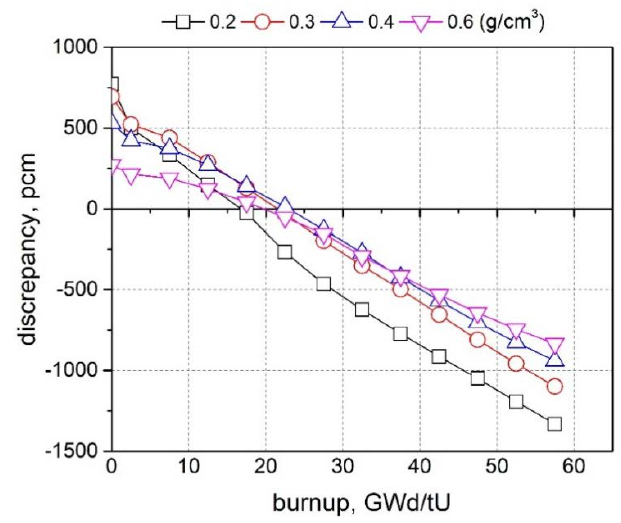
Figure 6. Difference in k inf between SCALE-6.2 and WIMS-10A codes as a function of burnup for various moderator densities for BWR pin-cell model.